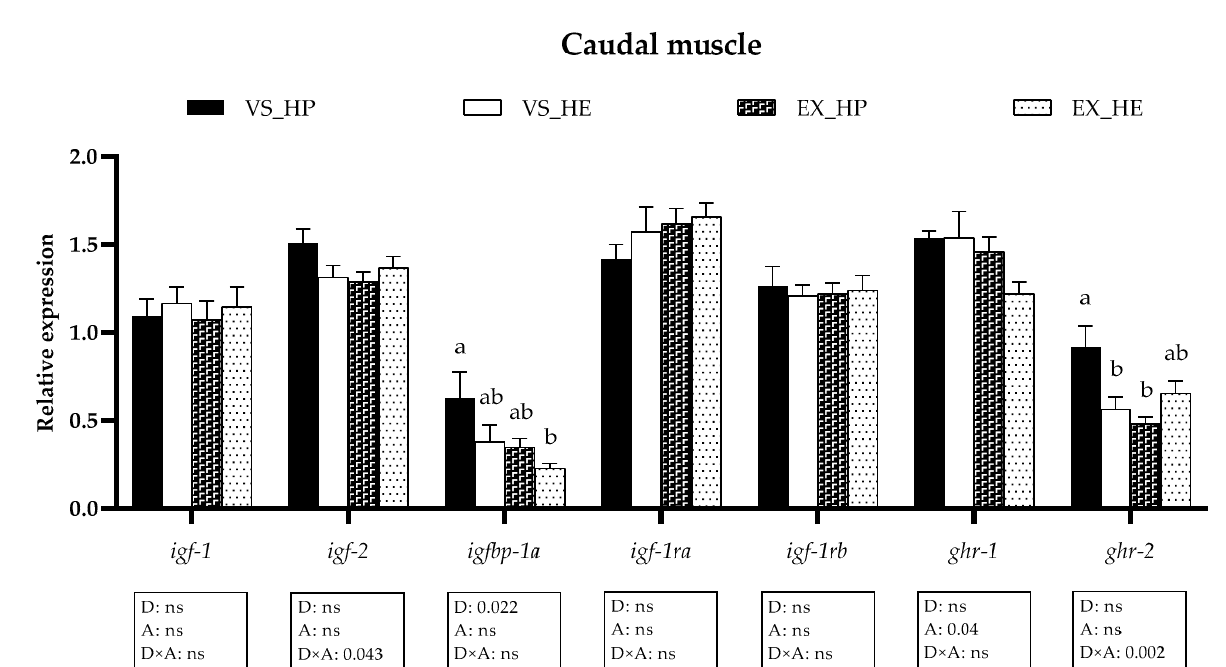
Figure 4. Relative gene expression of the GH-IGFs axis members in caudal muscle of fish under voluntary swimming (VS) or sustained exercise (EX) and fed with high-protein diet (HP) or high-energy diet (HE). Data are shown as means + SEM. VS, n = 12; EX, n = 16. Factorial statistical analysis was assessed by two-way ANOVA and p -values of factors diet (D), physical activity (A), and interaction (D × A) are displayed under the graph. Different letters indicate significant differences (Tukey’s post-hoc test, p < 0.05).